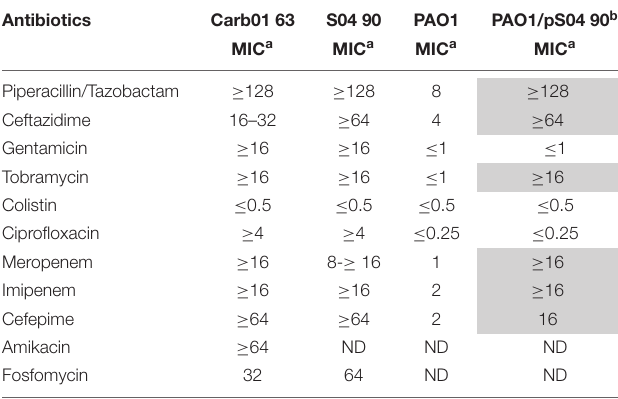
TABLE 1 | Antibiograms of strains Carb01 63, S04 90, PAO1, and a transconjugant of PAO1 carrying pS04